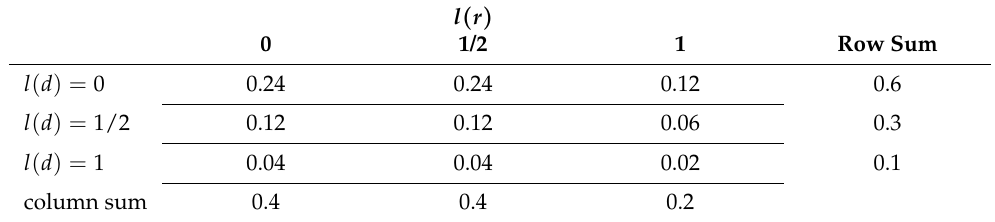
Table A1. Example joint PMF of bounded loss function, for r ∼ D R and d ∼ D D . The attack strategy in Theorem 1 outperforms the attack strategy in Theorem 2 on these